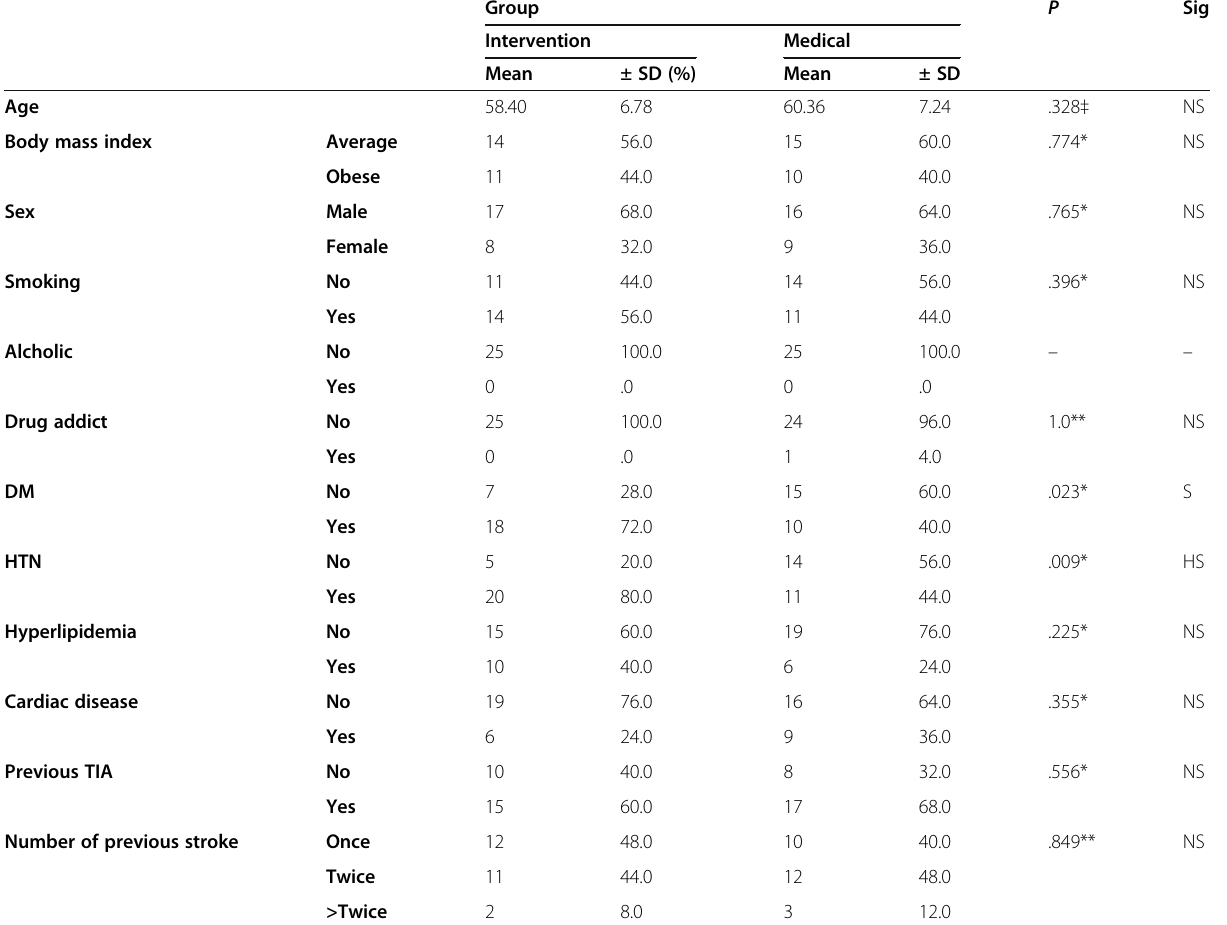
Table 1 Comparison of demographic data and RFs between the two study groups